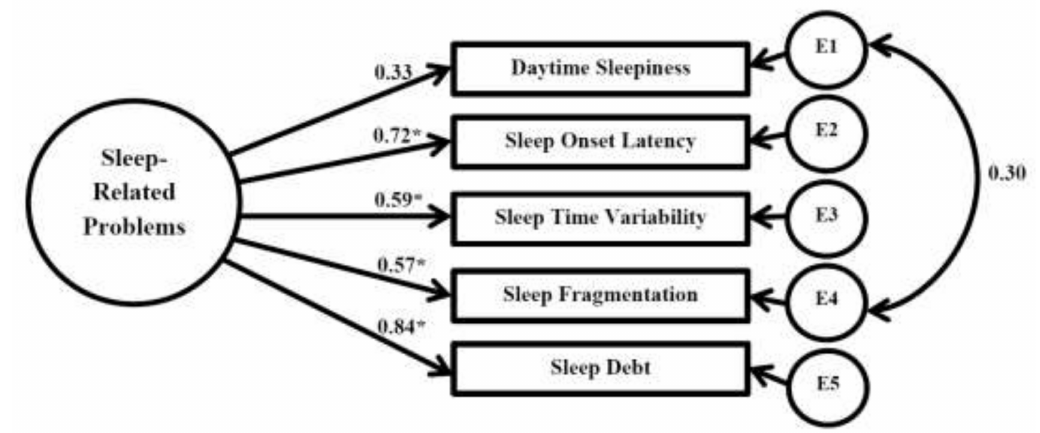
Figure 1. Confirmatory factor analysis: Modified sleep-related problems; * Significant ( p ≤ 0.05);